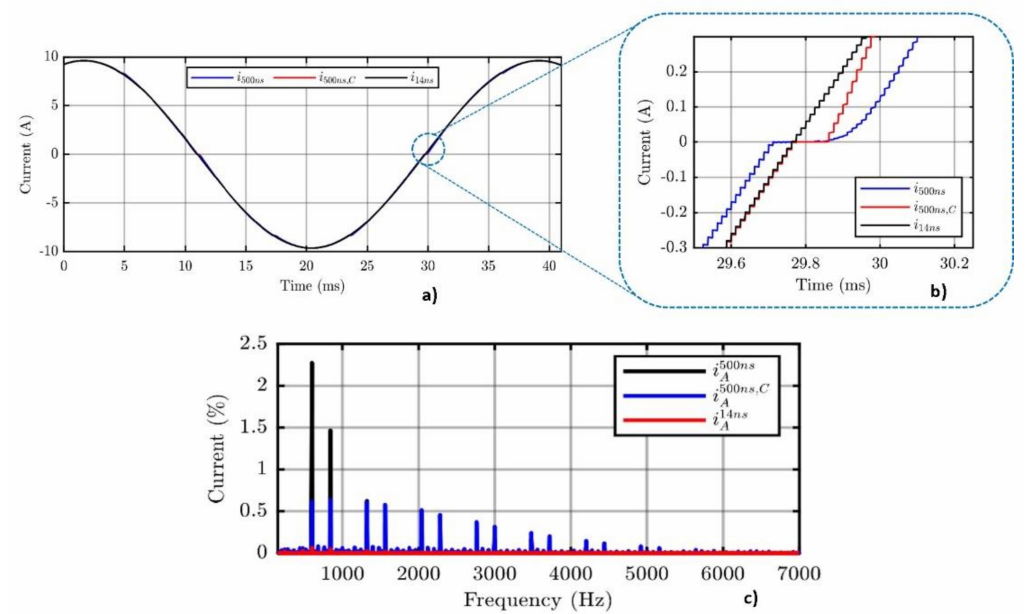
Figure 18. ( a ) Dead time effect on the current waveform of phase a in the three cases. ( b ) Zoomed view of current zero crossing in the three cases. ( c ) Harmonic content comparison for the load current in the case of dead times equal to 14 ns, 500 ns and 500 ns with compensation.